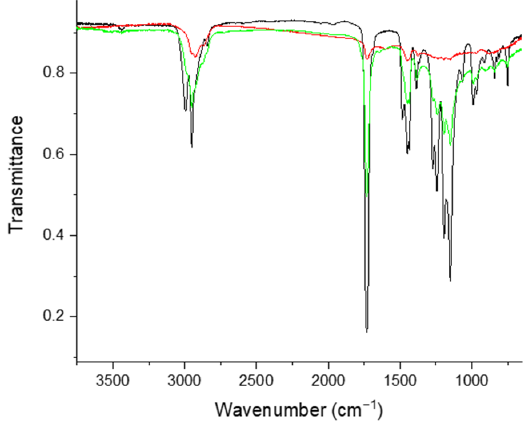
Figure 5. FT-IR spectra of PMMA thin film acquired during ion irradiation at different ion fluences: pristine PMMA (black line), after 1.3 × 10 15 ions × cm − 2 (green line) and after 9.6 × 10 15 ions × cm − 2 (red line) ion irradiation (200 keV H + ).